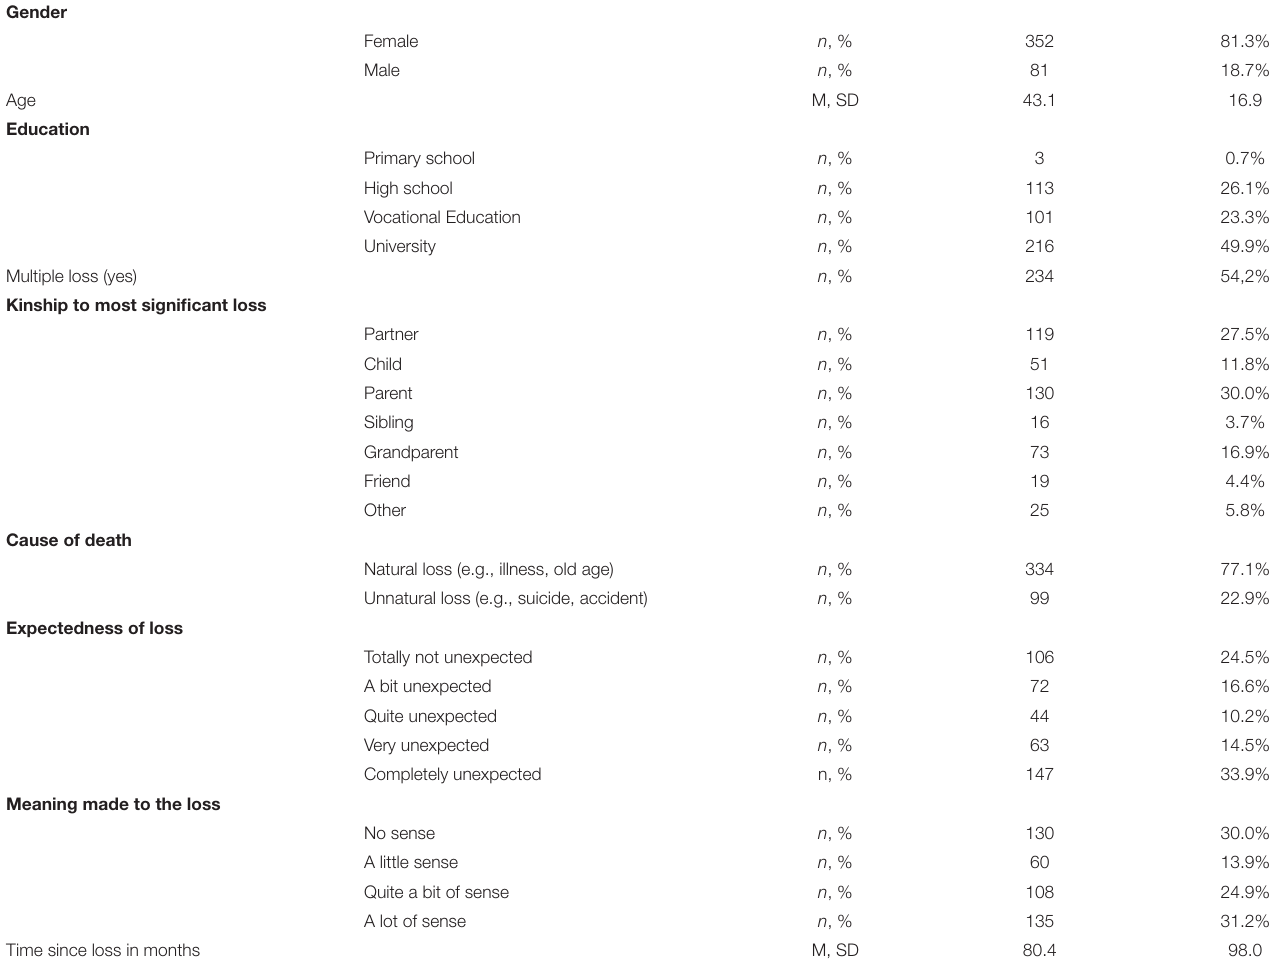
TABLE 1 | Sociodemographic and loss-related characteristics ( N = 433). Gender